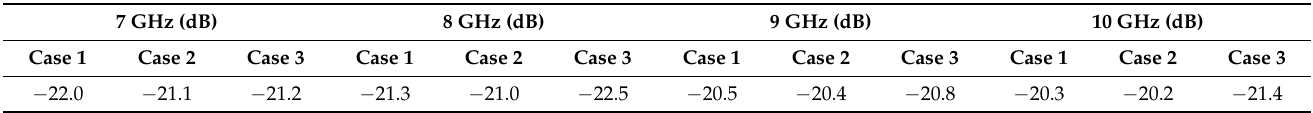
Table 6. The PSLLs after applying the proposed low PSLL beampattern synthesis approach at 7 GHz, 8 GHz, 9 GHz and 10 GHz.